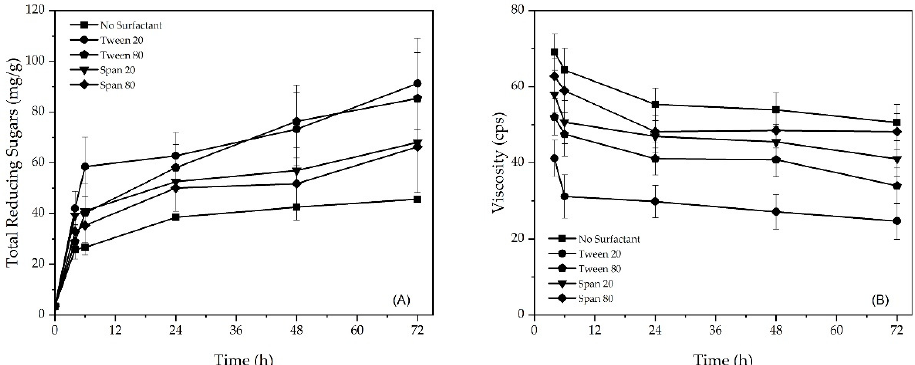
Figure 1. The effects of surfactant type at the different reaction times on the formation of reducing sugars ( A ) and solution viscosity ( B ). The chitosan concentration and surfactant concentration were 1% ( w / v ) and 7% ( w / w ). 1% ( w / v ) and 7% ( w / w